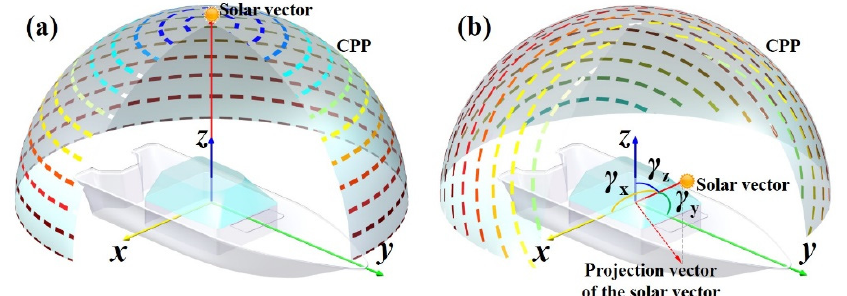
Figure 1. Spatial relationship between CPP, the solar vector and platform body axes when the sun (denoted as origin dot) is on the zenith point ( a ) and is nor near the zenith ( b ). The yellow, green, and blue arrows are body axes of the platform. The colored lines on the hemisphere represent E- vectors.